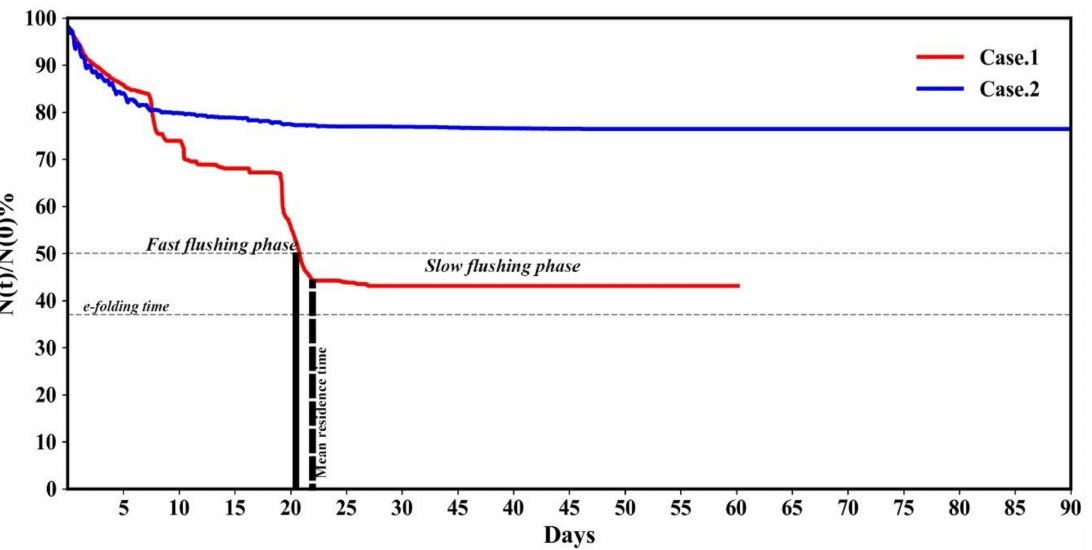
Figure 17. The residence time of CE is shown during the control run experiments of Case 1 (tide OFF and river ON) and Case 2 (tide ON and river OFF). Red and blue lines indicate the residence time patterns of CE in Case 1 and Case 2, respectively. N (0) is the initial number of particles in the domain and N (t) is the number of particles at time t .